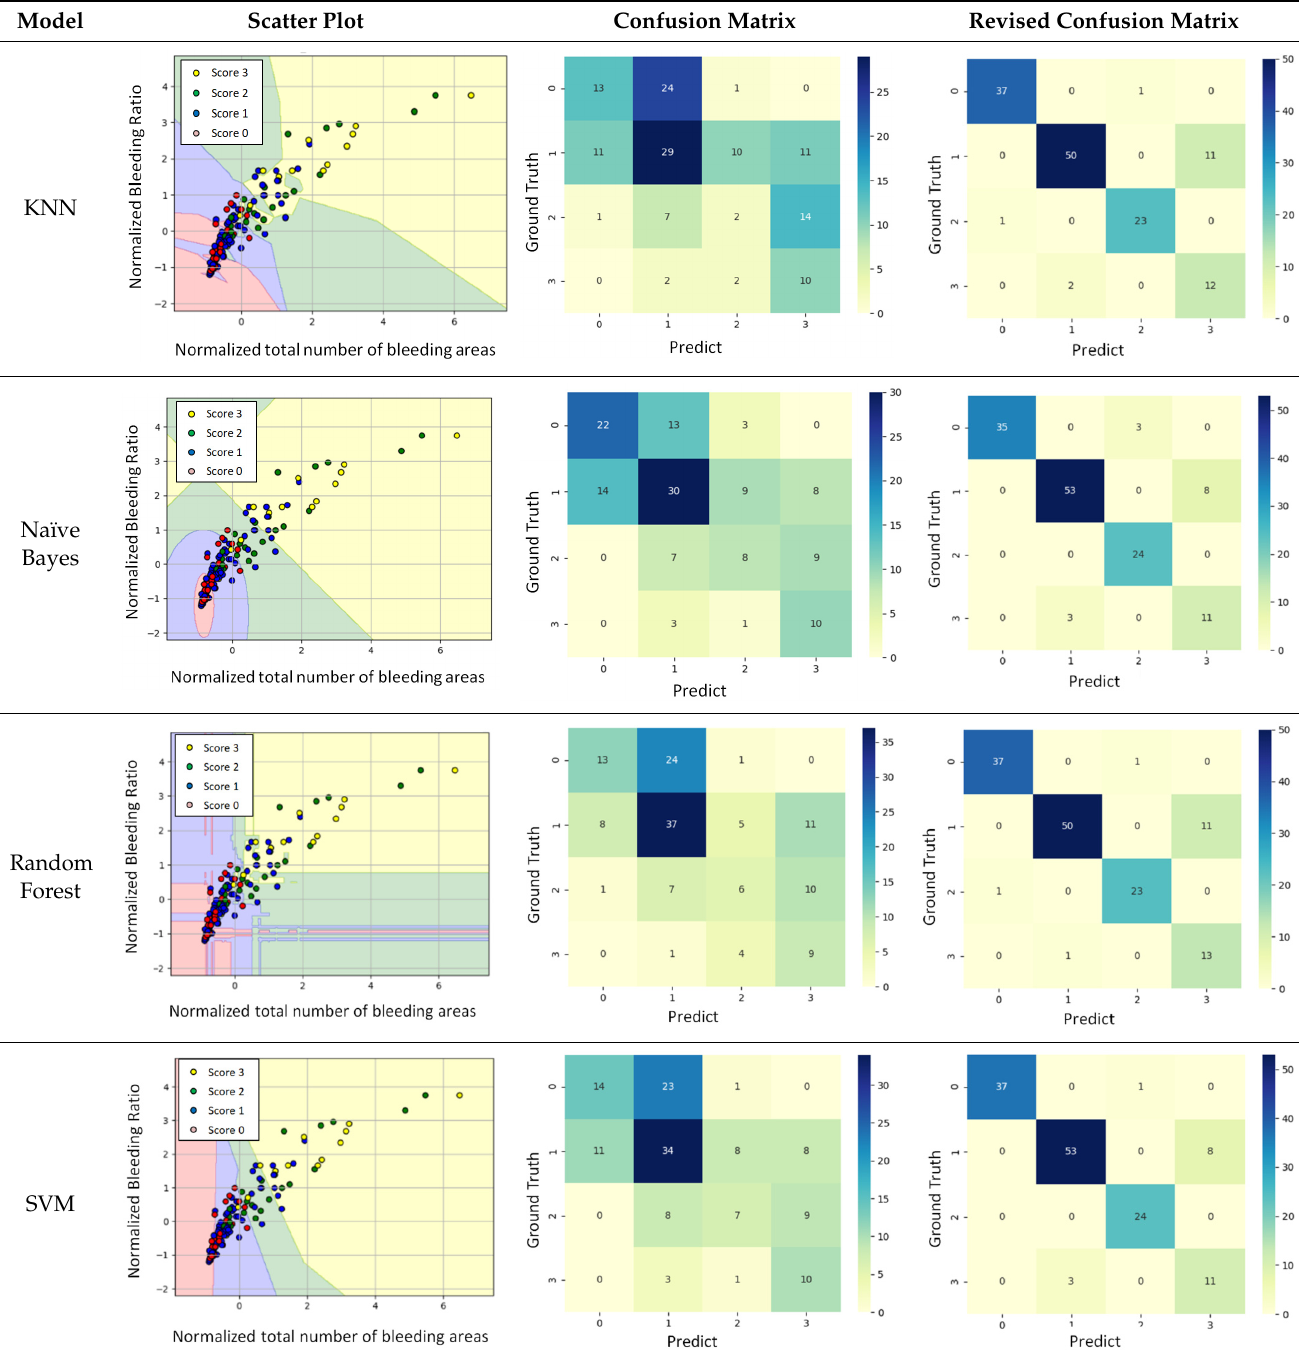
Table 2. Qualitative comparison of the four machine learning models for evaluating the levels of blood loss in the testing